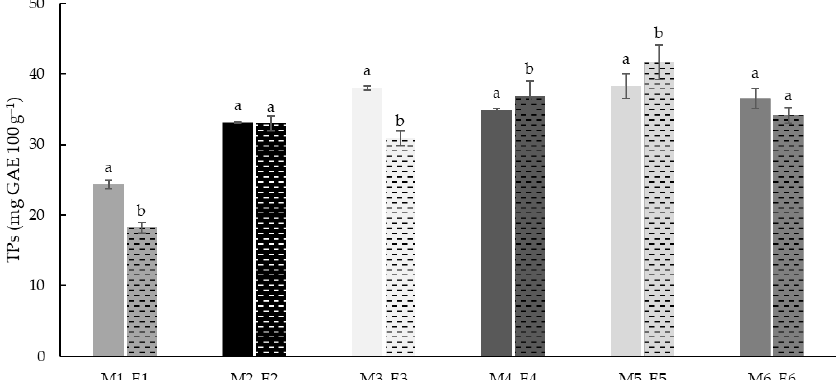
Figure 4. Total phenols (TPs) of native (M1–M7) and extruded (E1–E7) blend flour samples. The values are expressed as mg gallic acid equivalent (GAE) 100 g − 1 of dry matter. Different letters indicate significant differences ( p < 0.05) in TPs between non-extruded (M) and extruded (E) flours, for each blend formulation.